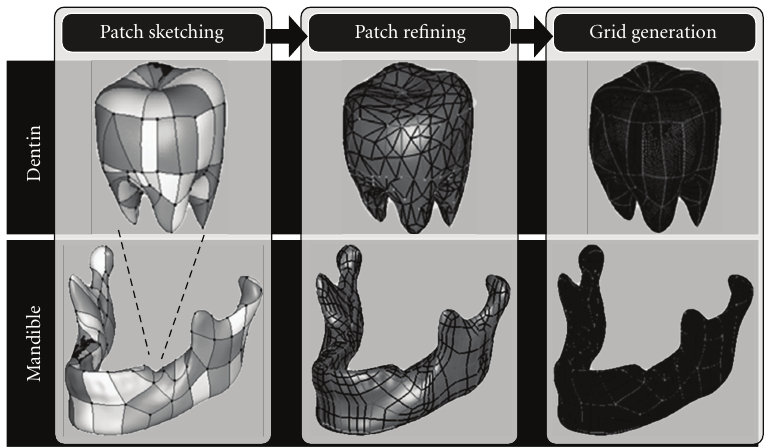
Figure 9: Processes involved in the NURBS object modeling